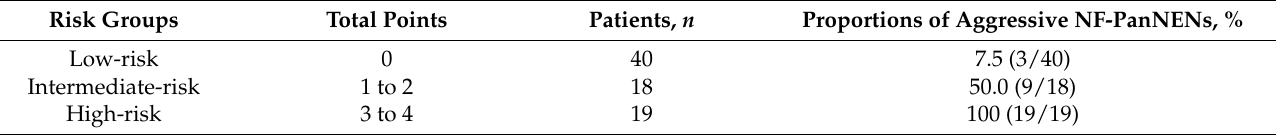
Table 6. Proportions of aggressive NF-PanNENs according to the risk